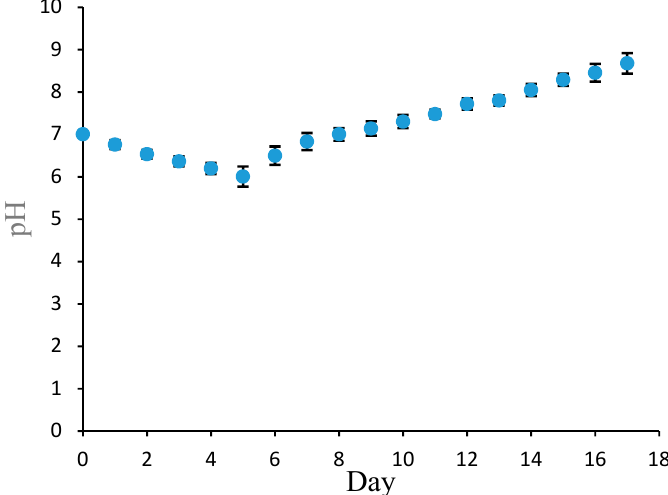
Figure 7. The response of the Pe/CI optical pH sensor on the fresh fish sample from day 0 to day 17.